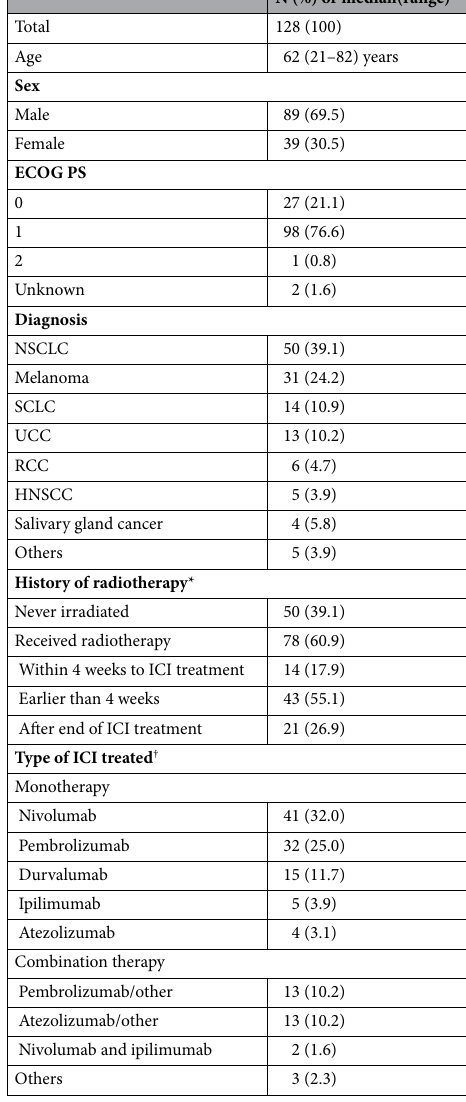
Table 1. Patient characteristics. ECOG PS eastern cooperative oncology group performance status, NSCLC non-small cell lung cancer, SCLC small cell lung cancer, UCC urothelial carcinoma, RCC renal cell carcinoma,